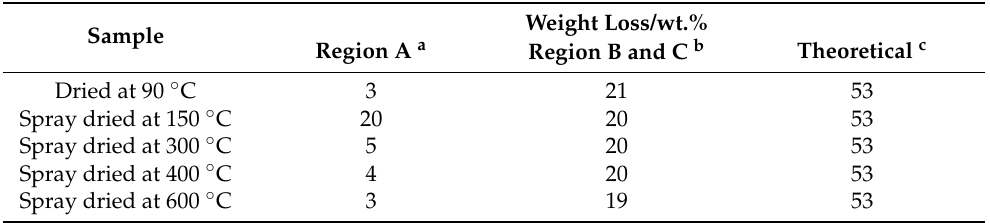
Figure 6. TGA results of solid products collected after drying and spray drying of a suspension of nanosized zeolites from hydrothermal synthesis. Spray drying (SD) was performed at 150, 300, 400 and 600 °C. The thermograms ( a ) show weight losses in different temperature ranges. Temperature range A is mostly due to desorption of physisorbed water from the samples. Region B is due to the decomposition and total oxidation of the template. Region C is due to the dehydroxylation of internal and external silanol groups as well as due to the removal of the remaining gaseous products from the decomposition of the template. ( b ) Shows regions B and C of thermograms of two samples for better visualization of the effect of spray drying temperature on the stability of the template. The signal in the derivative at about 350°C indicates clearly that after the short spray drying at about 400°C the template is still table and useful for the further crystallization process. Table 1. Summary of the weight losses measured on dried and spray-dried samples by using TGA. The weight loss regions A, B and C were taken from Figure 6.